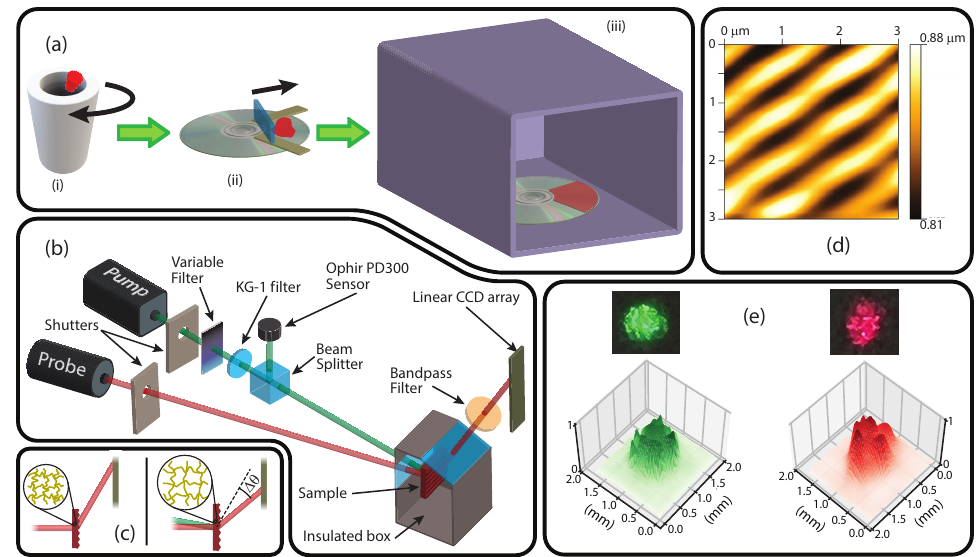
Figure 1. ( a ) Illustrated steps for fabricating the dye-doped PDMS sample including (i) mixing and centrifuging under vacuum, (ii) pouring between guides and blade coating, and (iii) placing in an oven to cure. ( b ) The optical experiment with a probe beam for measuring the coefficient of thermal expansion as well as the pump laser power. ( c ) Illustration of an elastomer expanding via photothermal heating, where the stretched diffraction grating causes the diffracted probe beam’s angle to decrease. ( d ) An AFM image of the grating structure on the surface of the PDMS sample. ( e ) The beam profiles incident at the sample plane for the pump and probe